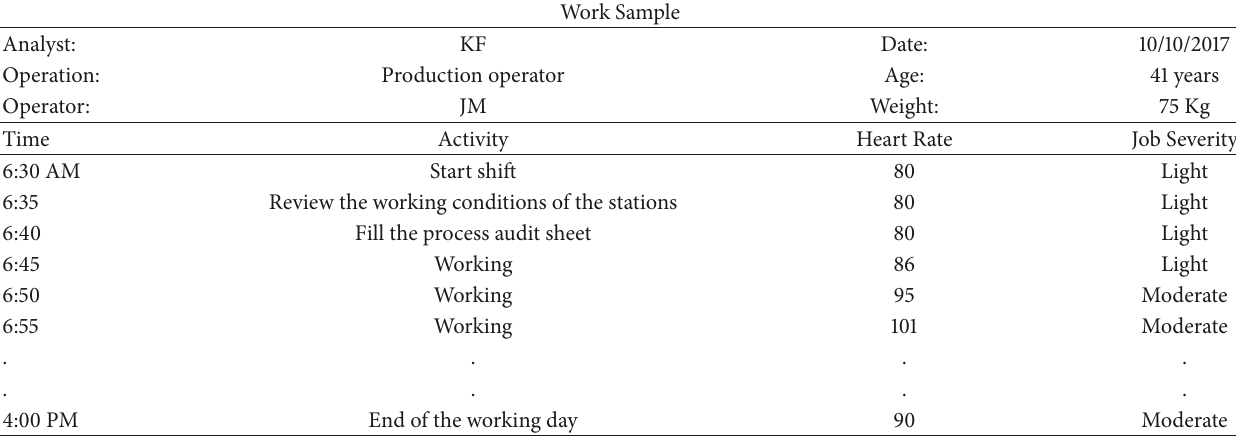
Table 2: Section of work shift schedule selected for sampling, performed by one of the operators. Work